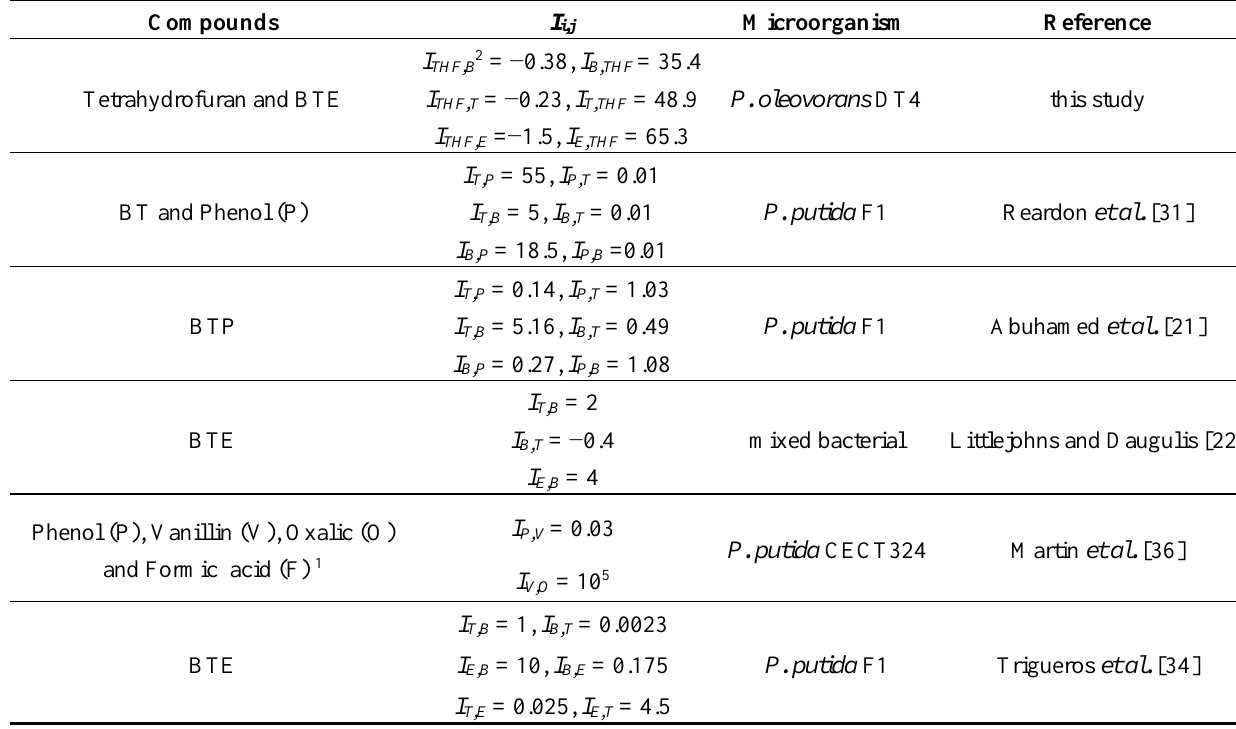
Table 2. Interaction parameters estimated from sum kinetics with interaction parameter (SKIP) model for dual